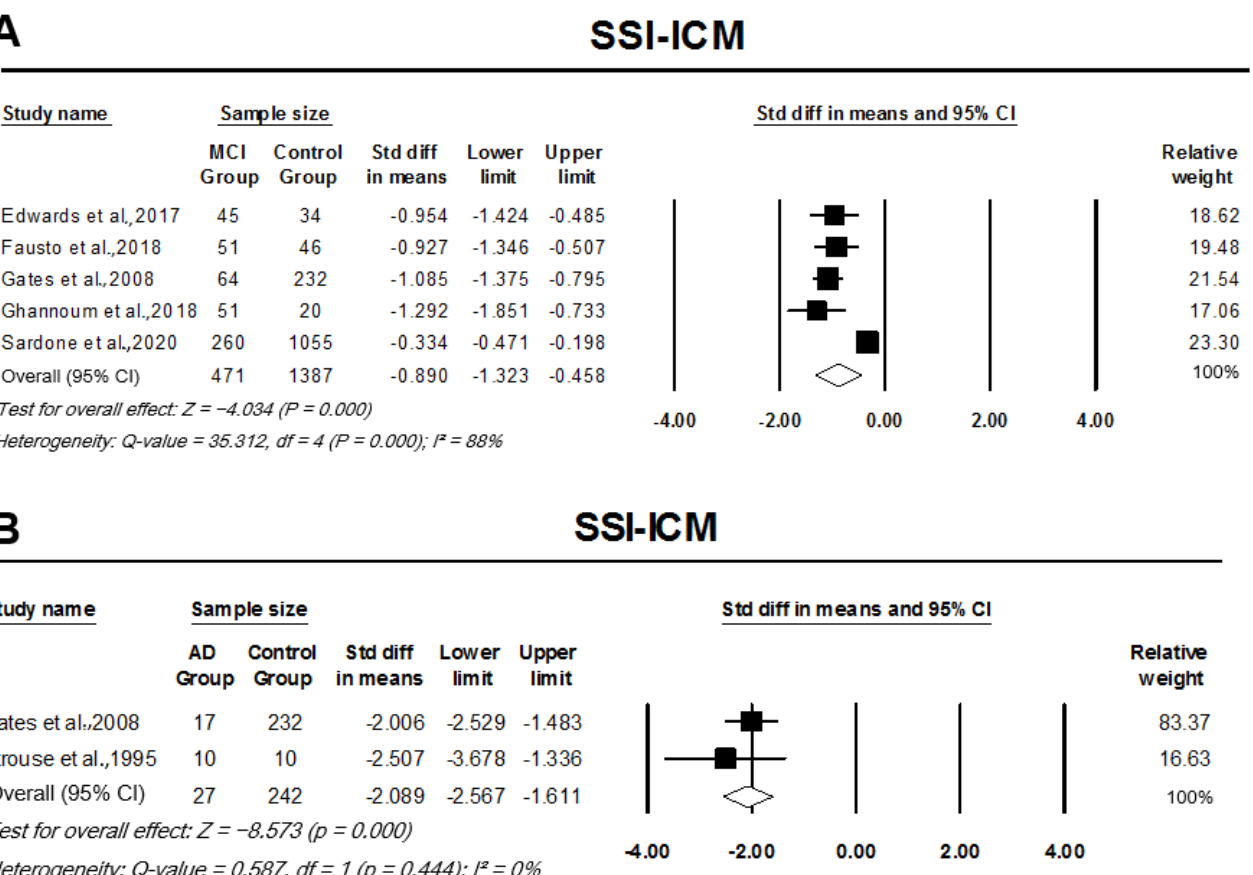
Figure 7. Forest plot of standard mean difference and overall (pooled) estimate of studies investigating synthetic sentence identification-ipsilateral competing message (SSI-ICM) test. ( A ) Analysis of SSI-ICM between the mild cognitive impairment (MCI) group and the control group; ( B ) analysis of SSI-ICM between the Alzheimer’s disease (AD) group and the control group. Notes: Z = Z score; I 2 = percentage of heterogeneity; Q-value = Cochrane’s Q; df = degrees of freedom. The horizontal lines represent the 95% confidence interval (CI) for each computed standard mean difference. Weights are from the random-effects